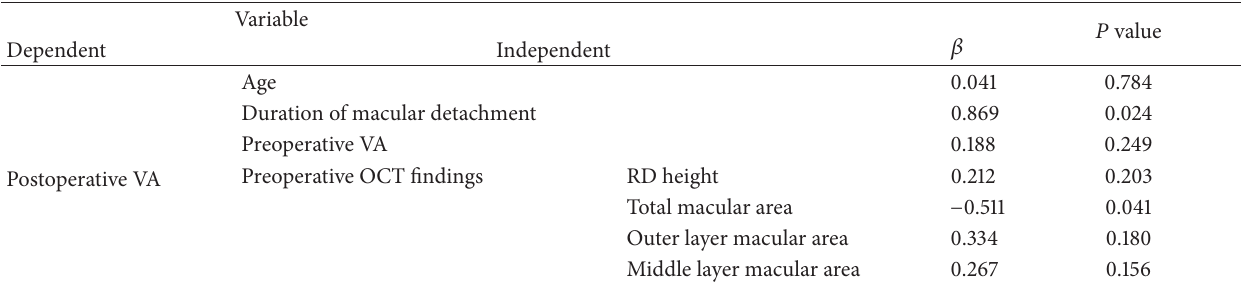
Figure 2: Correlation of preoperative clinical findings to 6-month postoperative best-corrected visual acuity (BCVA). There was a positive correlation between preoperative and 6-month postoperative BCVA ((a); 𝑟 = 0.48 , 𝑃 < 0.001 ). There was also a positive correlation between retinal detachment height and 6-month postoperative BCVA ((b); 𝑟 = 0.47 , 𝑃 < 0.001 ). There was a negative correlation between the cross- sectional area of the inner macular layer and 6-month postoperative BCVA ((c); 𝑟 = −0.43 , 𝑃 = 0.001 ). There was also a negative correlation between total macular cross-sectional area and 6-month postoperative BCVA ((d); 𝑟 = −0.44 , 𝑃 < 0.001 ). Table 2: Multiple regression analysis for independent factors contributing to 6M postoperative